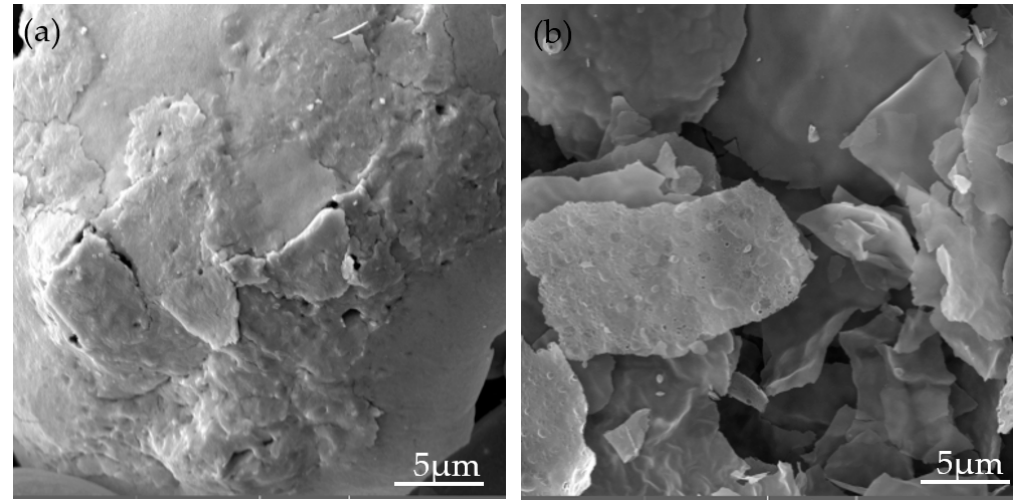
Figure 14. SEM analysis of the products CeO 2 when the mass fraction of citric acid changed: ( a ) 0.00 and ( b ) 0.04.